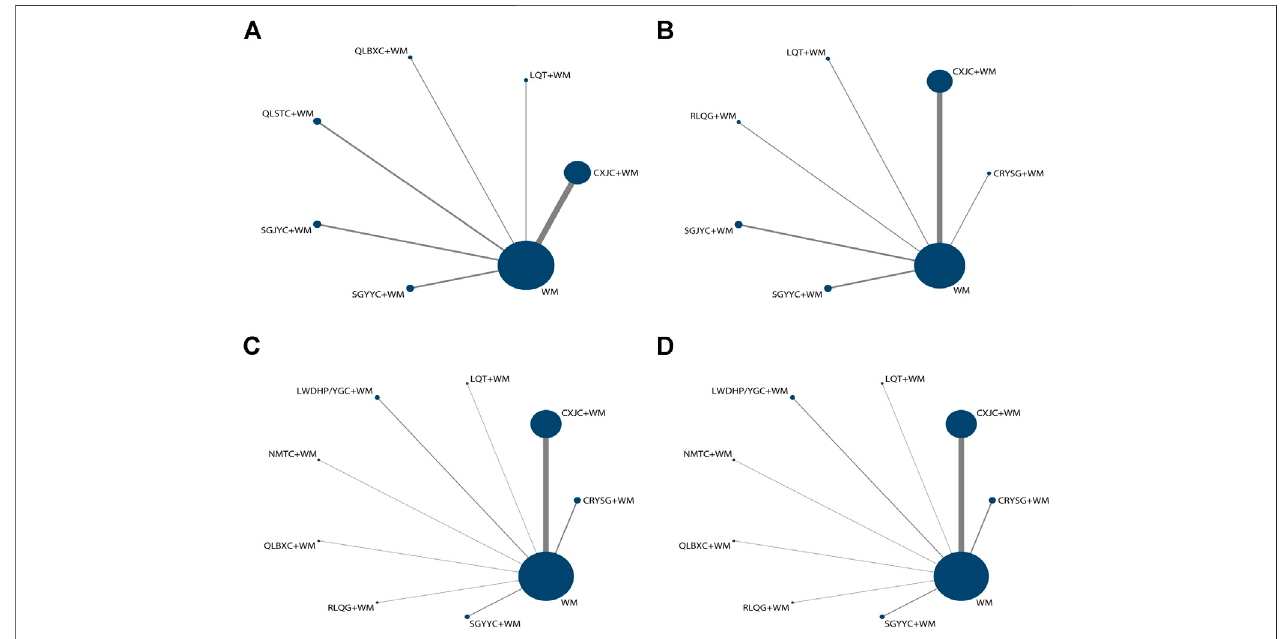
FIGURE 3 | Network graphs for various outcomes (A) NIH-CPSI; (B) IIEF-5; (C) the clinical effective rate of CP/CPPS; (D) the clinical effective rate of SD.